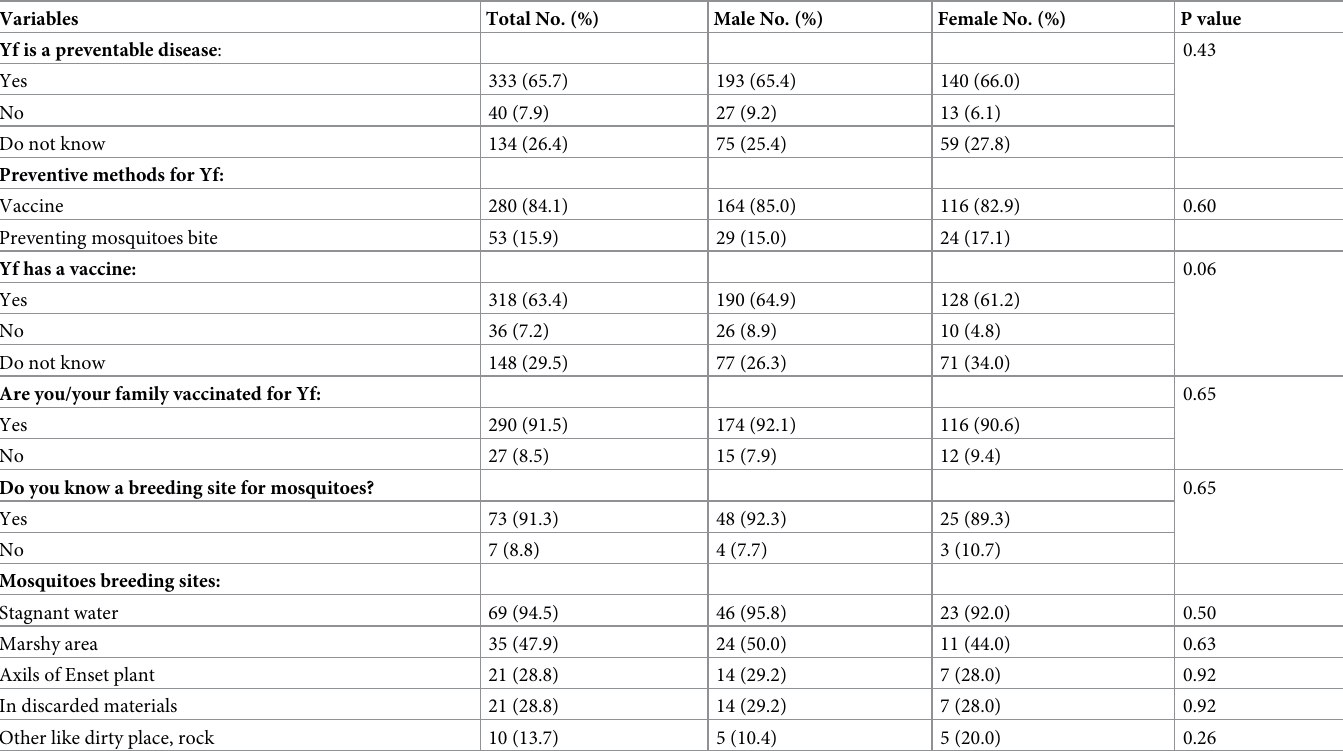
Table 4. Community’s practices regarding prevention of Yf as reported by the study participants.